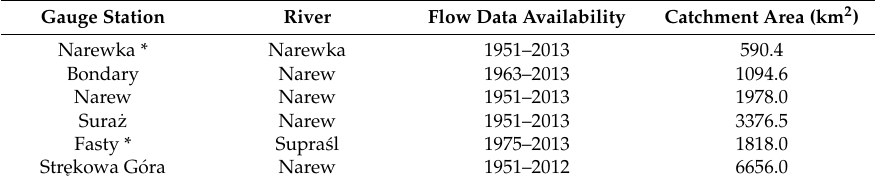
Table 1. Gauge stations in the Upper Narew Catchment. The asterisk ‘*’denotes catchments of major tributaries of the Narew River, which are used as references in this